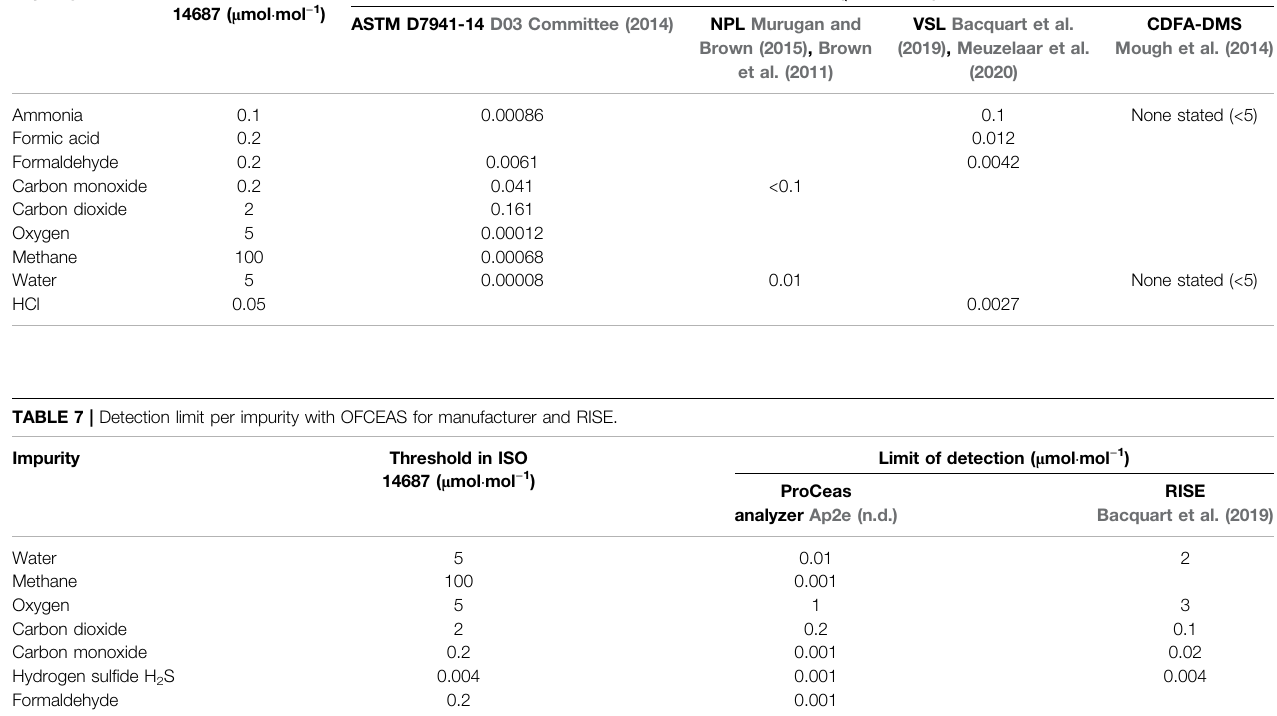
TABLE 6 | Detection limit per impurity with CRDS for NPL, VSL, CDFA-DMS and ASTM D7941-14. Impurity